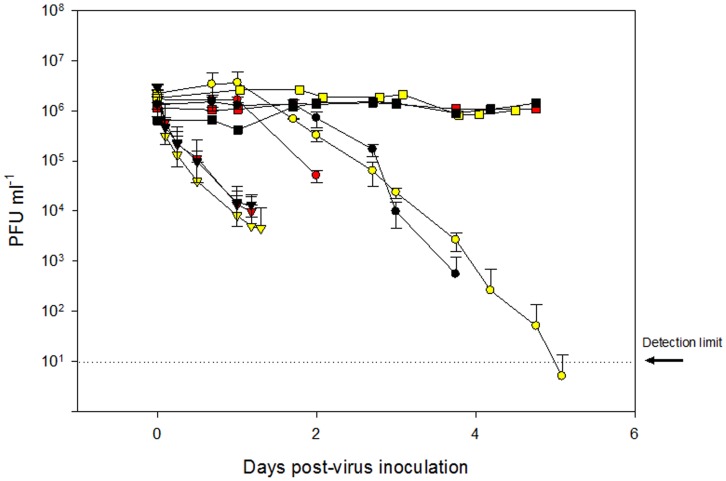
Decay of infectivity of IHN virus in sterile (squares), closed (circles), and open (triangles) seawater systems that were seeded with IHNV and incubated in the dark at 8 (black), 10 (yellow), or 12 (red) degrees Celsius.Error bars represent standard deviation based on triplicate plaque assay counts.